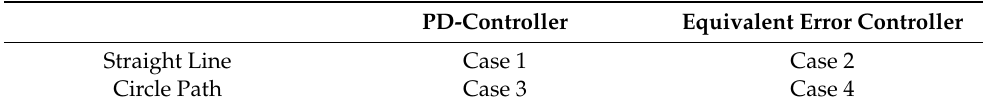
Table 1. The list of simulation